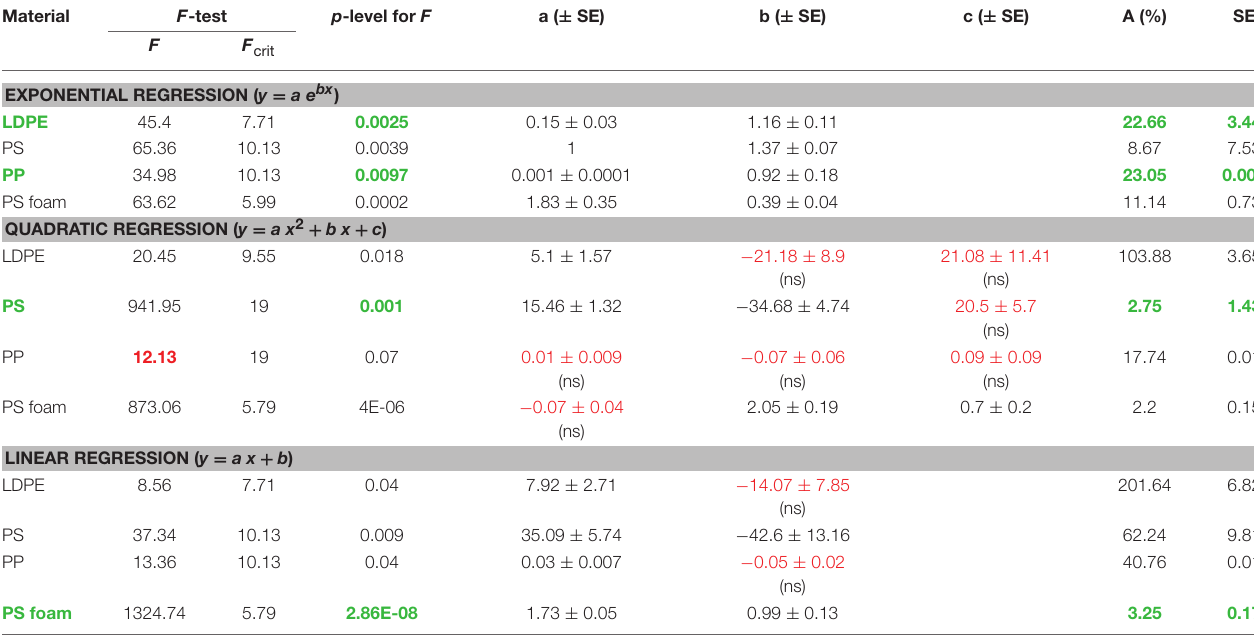
TABLE 3 | Results of statistical analysis of exponential, quadratic, and linear models for relationship between the mass of MPs and dimentionless time of the degradation experiment.